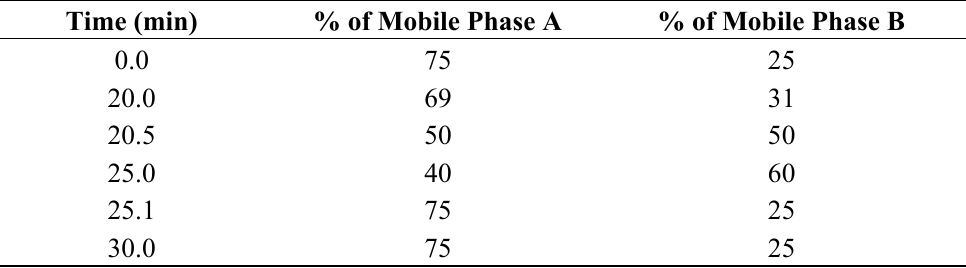
Table 2. RP-HPLC method for the identification and purificationof steviol glycosides 2 – 4 . Time